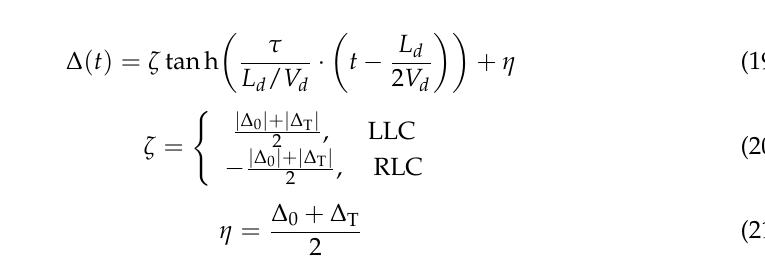
Figure 6. Schematic view of Rutting model: ( a ) Simplified trapezoid rutting shape; ( b ) rutting model in Carsim software (in case of WHR = 10).